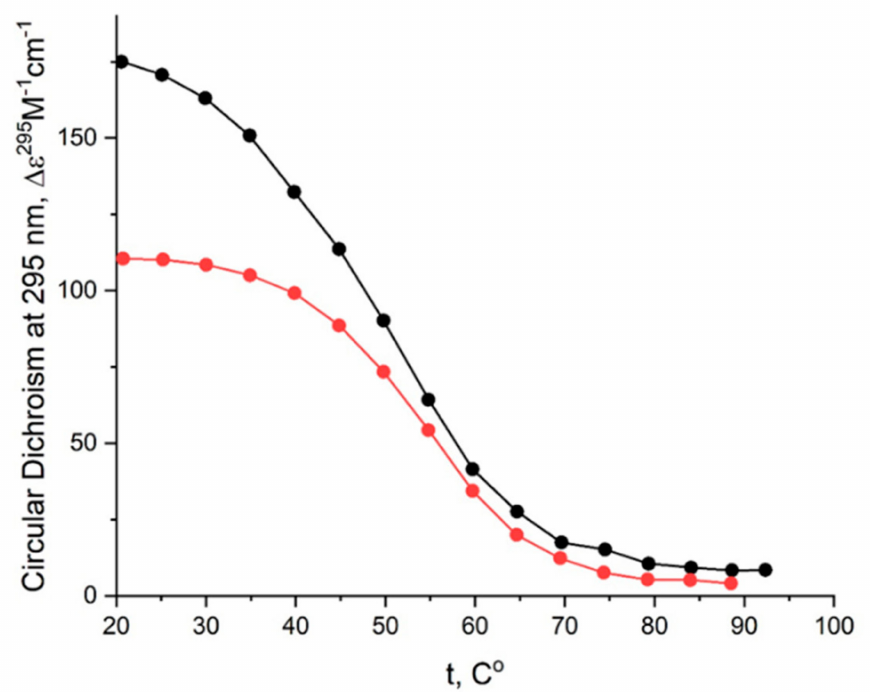
Figure A2. CD melting profile of GQs under study in the buffer C (140 mM NaCl, 10 mM KCl, 5 mM BaCl 2 ): HD1 (red), bi-HD1